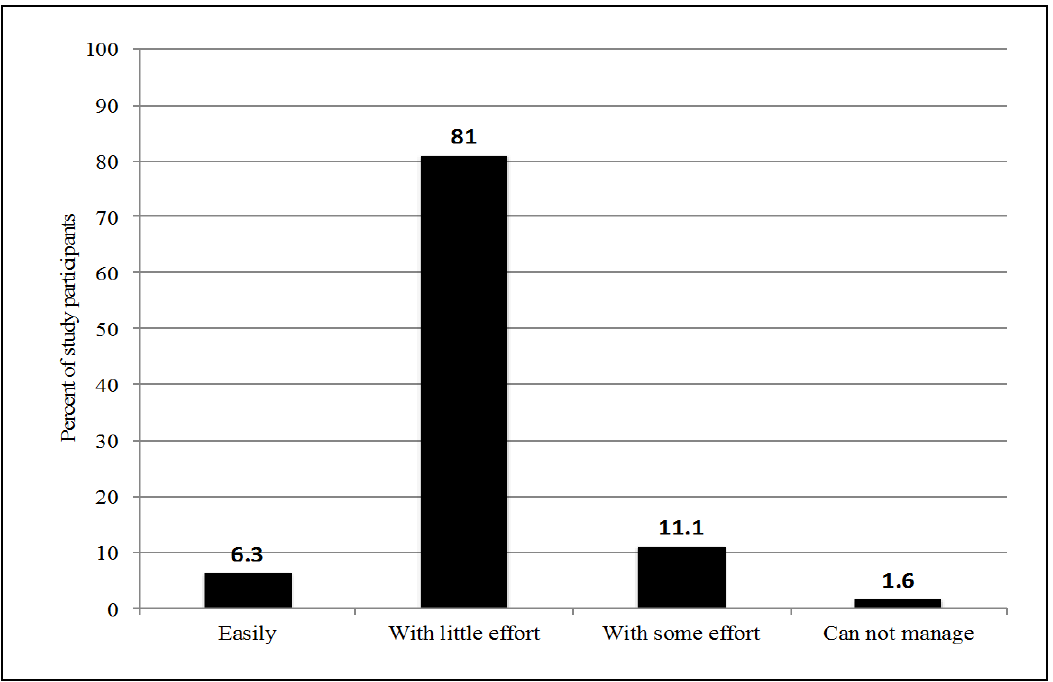
Figure 2. Management of tensions, stress and pressures